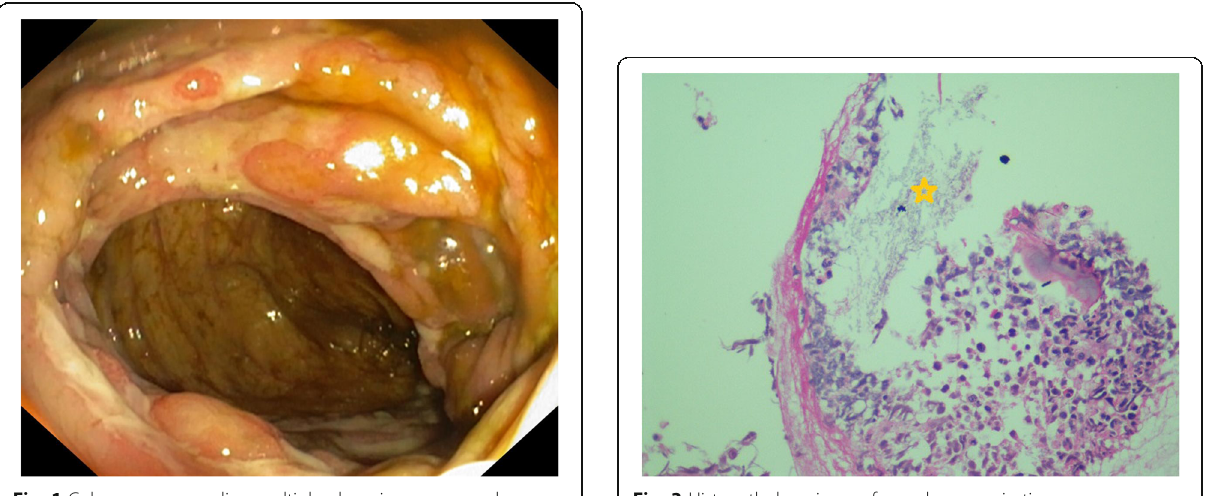
Fig. 1 Colonoscopy revealing multiple ulcers in caecum and over Fig. 3 Histopathology image from ulcer margin tissue demonstrating necrotic tissue with bacterial colonies (yellow